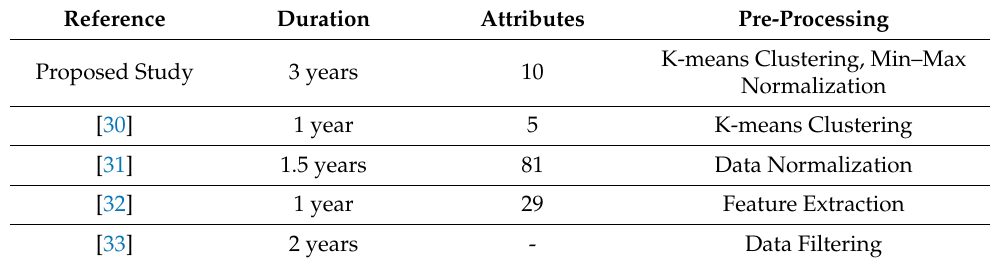
Table 4. Datasets